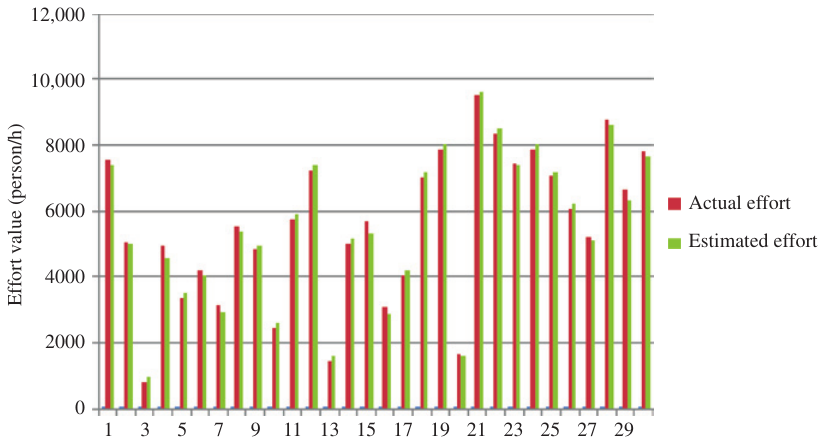
Figure 3: Graphical Representation of the Effort Values of the Desharnais Dataset.